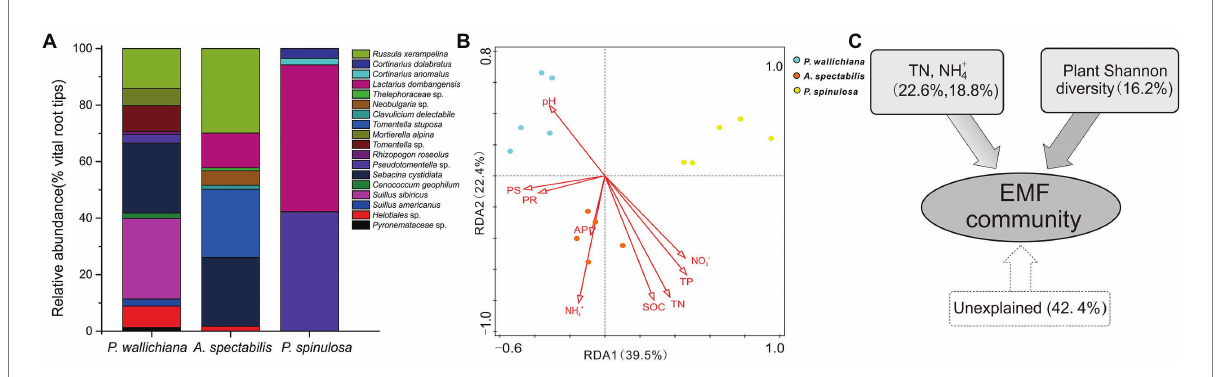
FIGURE 2 The community composition (A) , redundancy analysis (B) and variation partition analysis (C) of ectomycorrhizal fungal community across the three forests ( Pinus wallichiana , Abies spectabilis , and Picea spinulosa ). TN, total nitrogen; NH 4+ , ammonia